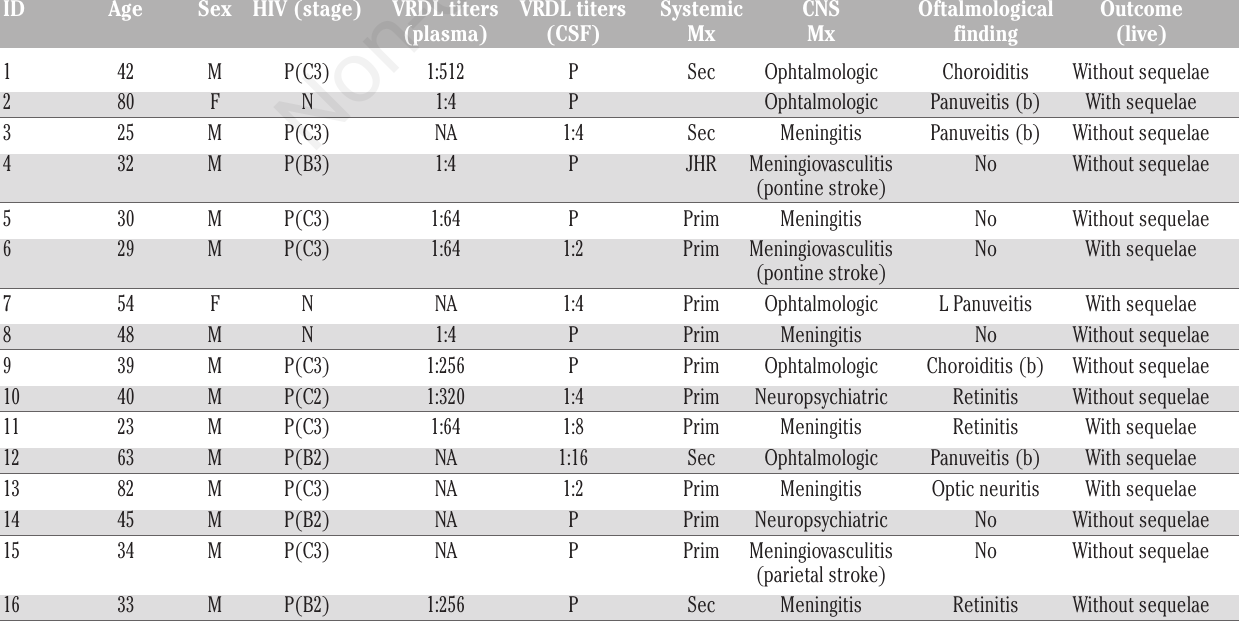
Table 2. Patient characteristics, HIV status and clinical